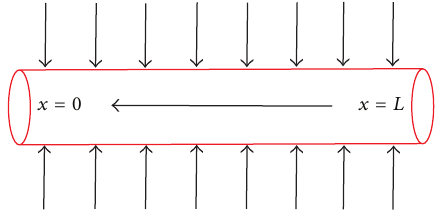
Figure 5: Coupling model between reservoir and